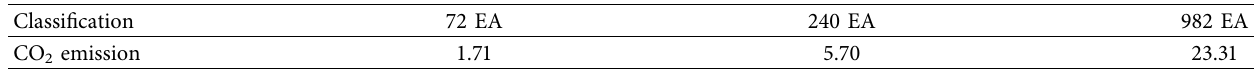
Table 2: CO 2 emissions for manpower.